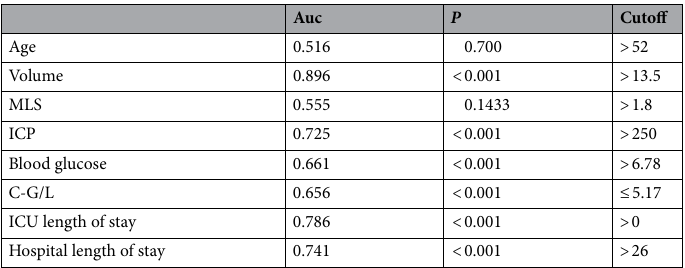
Table 1. Division of critical value. There is no theoretical basis for the grading of continuous variables such as Age, Volume, MLS, ICP, Blood glucose, C-G/L, and Length of stay. Thus, the ROC curve is selected to divide the critical value of continuous variables. MLS midline shift, ICP intracranial pressure, C-G/L cerebrospinal fluid glucose/cerebrospinal fluid lactate ratio.